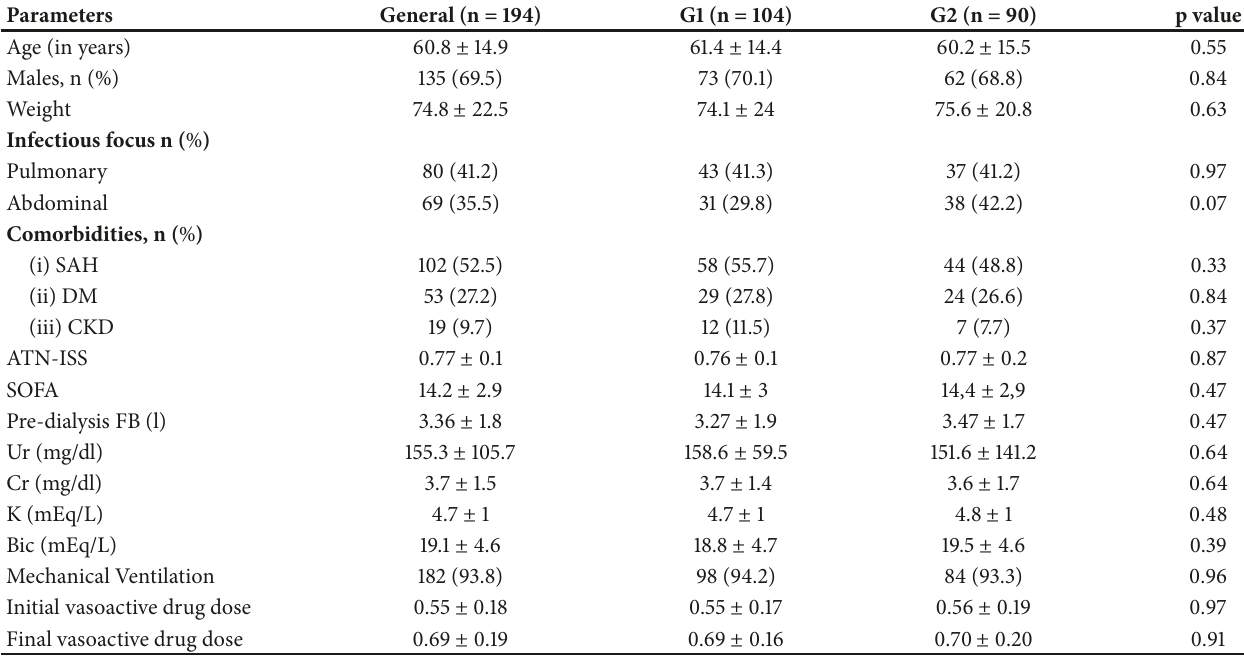
Table 1: Clinical and laboratory characteristics of patients with AKI treated with PHD.